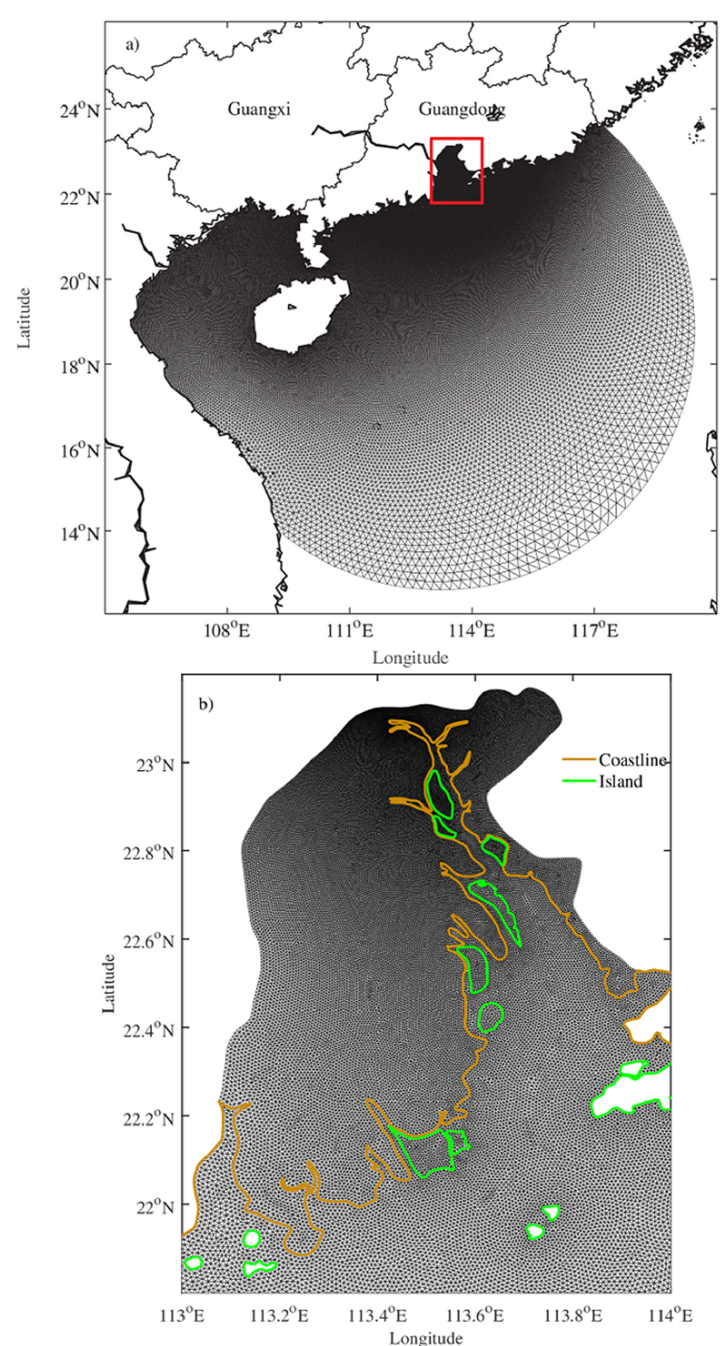
Figure 2. The unstructured mesh covering the computational domain for the ADCIRC (Advanced Circulation) + SWAN (Simulating Waves Nearshore) coupled model. ( a ) There are 110,055 nodes and 216,932 triangular elements in the mesh of ( a ). ( b ) is an enlarged view of the Pearl River Estuary (PRE) (the area in the red box of ( a )) with a horizontal resolution of 70 m–300